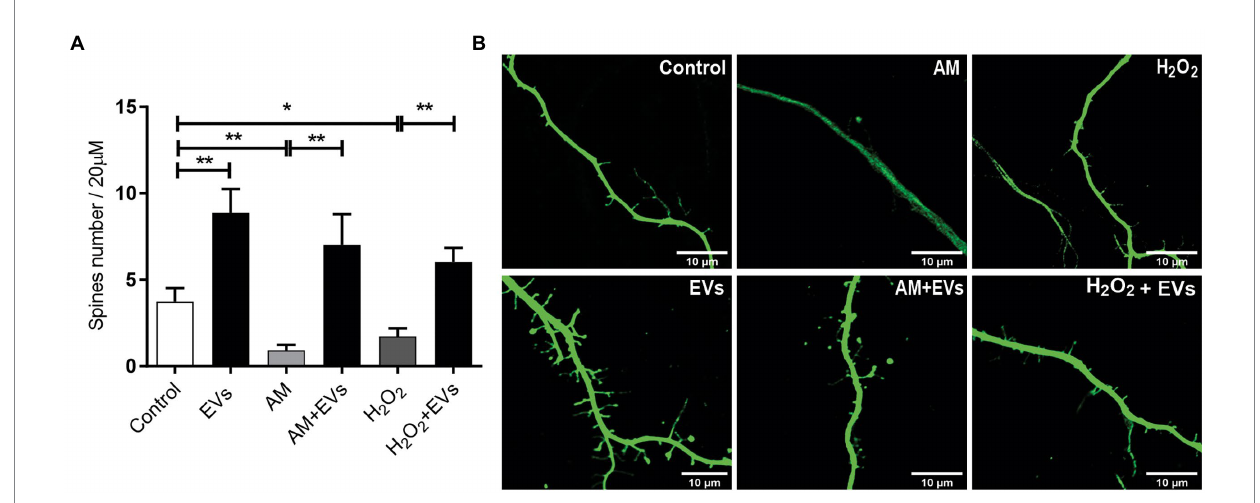
FIGURE 5 NSC-EVs promotes dendritic spines development even under stress conditions. (A) Quantification of spine number per 20 μ m of neurite length. Values of quantification are expressed as mean ± SEM *p < 0.05, ** p ≤ 0.01. (B) Representative images of dendritic spines (63X) under the indicated conditions after 3 days. Scale bar: 10 μ m.